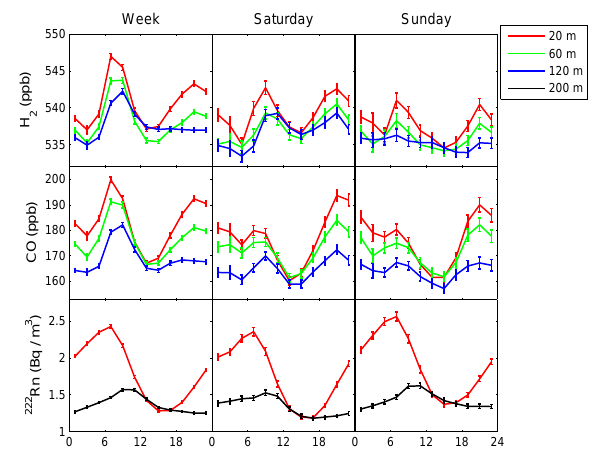
Fig. 7. Average diurnal cycles of H 2 , CO and 222 Rn, for week- days, Saturdays and Sundays. Each data point is the trimmed av- erage (discarding the 10% lowest and highest values) of a 2-hourly bin. The data between 03:00 and 04:00 were excluded, because the daily calibration took place mostly during this interval, thus the re- sults were possibly biased. For H 2 and CO, the data from the 200m height are not shown for the reason explained in Sect. 3. The error bars are standard errors of the means corresponding to 67% confi- dence